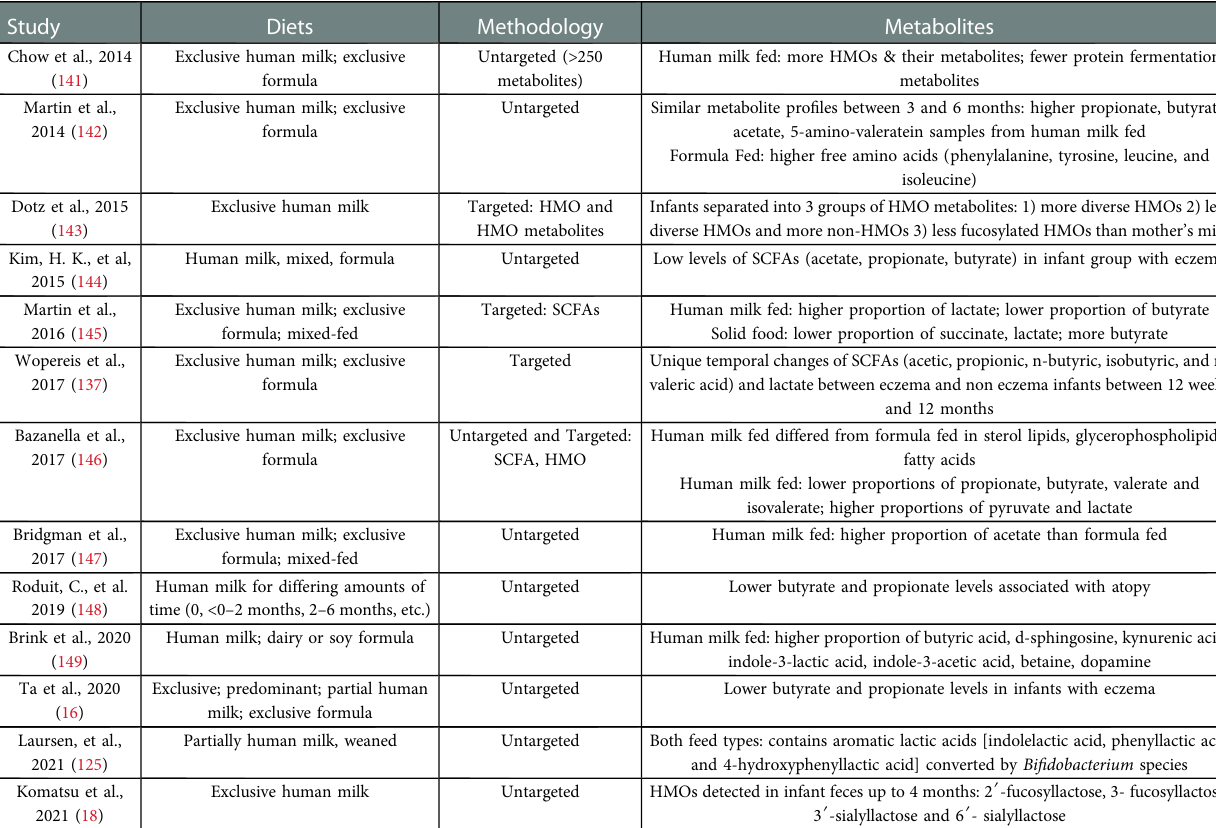
TABLE 3 Stool metabolites as they relate to infant diet and/or AD/eczema.